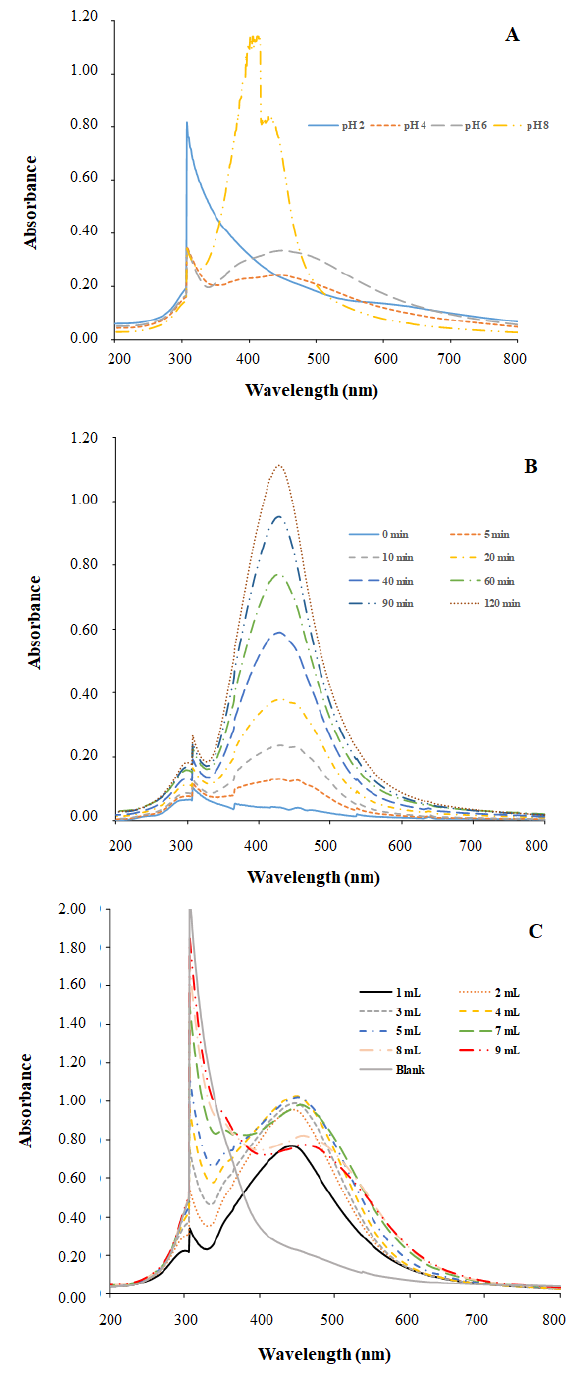
Figure 3. UV/Vis Spectra showing the influence of different parameters in the synthesis of Ag-NPs with the GS extract: ( A ) pH, ( B ) contact time and ( C ) extract addition.